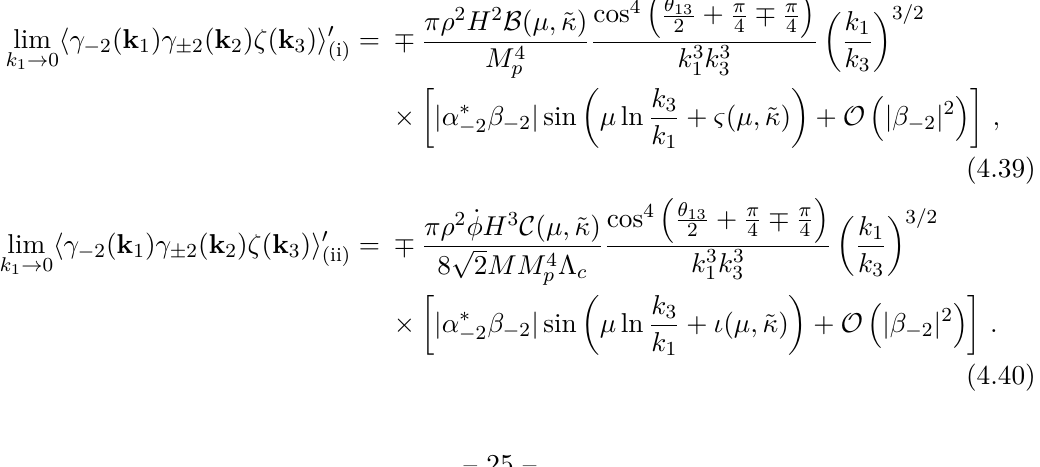
Figure 7 . The CC signals in the h γ λ potential ˜ κ . For the purpose of demonstration, here we have only shown two helicity choices, namely λ 1 = − 2 , λ 2 = +2 (left) and λ 1 = λ 2 = +2 (right). The other helicities can also be calculated in a similar fashion. The correlator is normalized by ( k 3 /k 1 ) 9 / 2 k 6 the upper panels showing the full result and the lower panels showing the oscillatory CC signal only. The blue solid lines correspond to the analytical cut result while the red dashed lines correspond to numerical results (the signals are filtered from the total numeric integration result using high-pass filters with a Blackman window